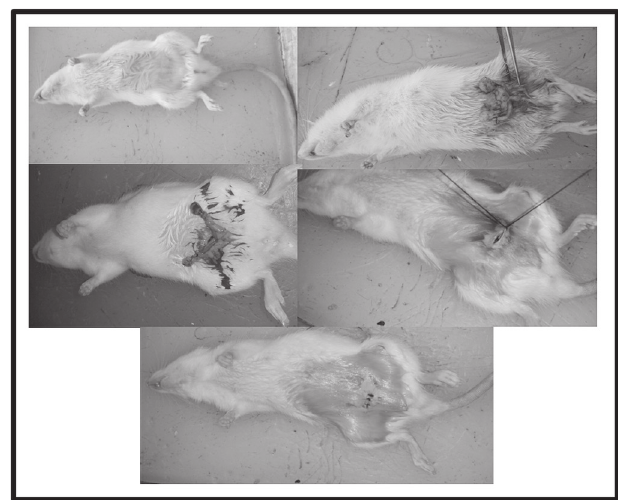
FIGURE 1 - Surgical procedure of ovariectomy